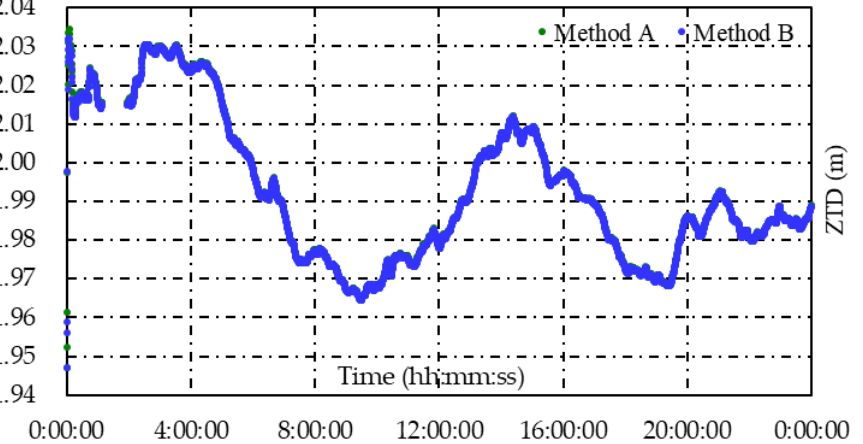
Figure 8. ZTDs from static PPP with methods A and B.